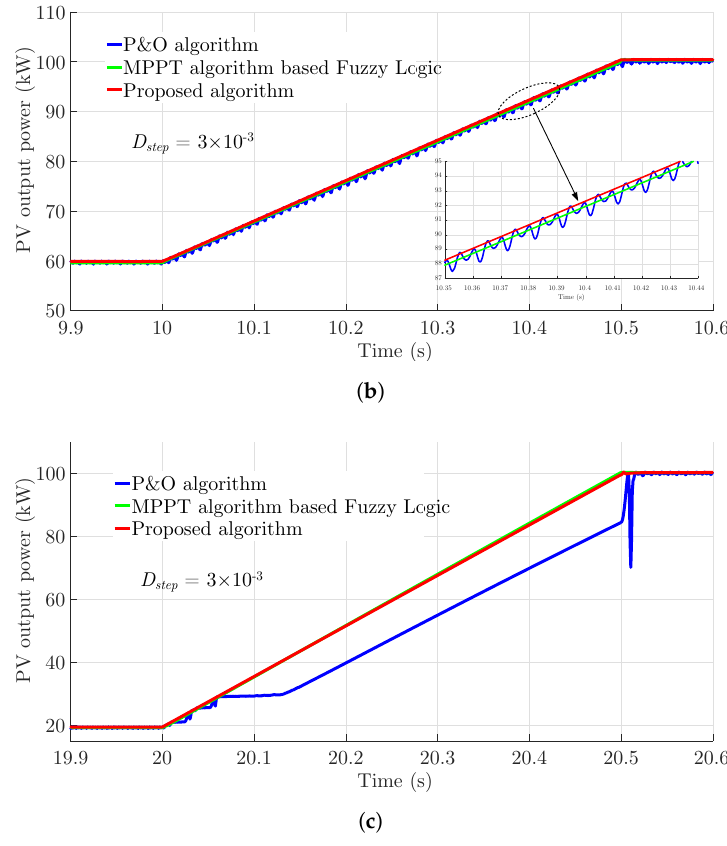
Figure 17. Comparison of the output power in the case of solar radiance increasing rapidly within 0.5 s periods and with D step = 3 × 10 − 3 : ( a ) solar radiance increase from 200 W/m 2 to 600 W/m 2 ; ( b ) solar radiance increase from 600 W/m 2 to 1000 W/m 2 ; ( c ) solar radiance increase from 200 W/m 2 to 1000 W/m 2 .